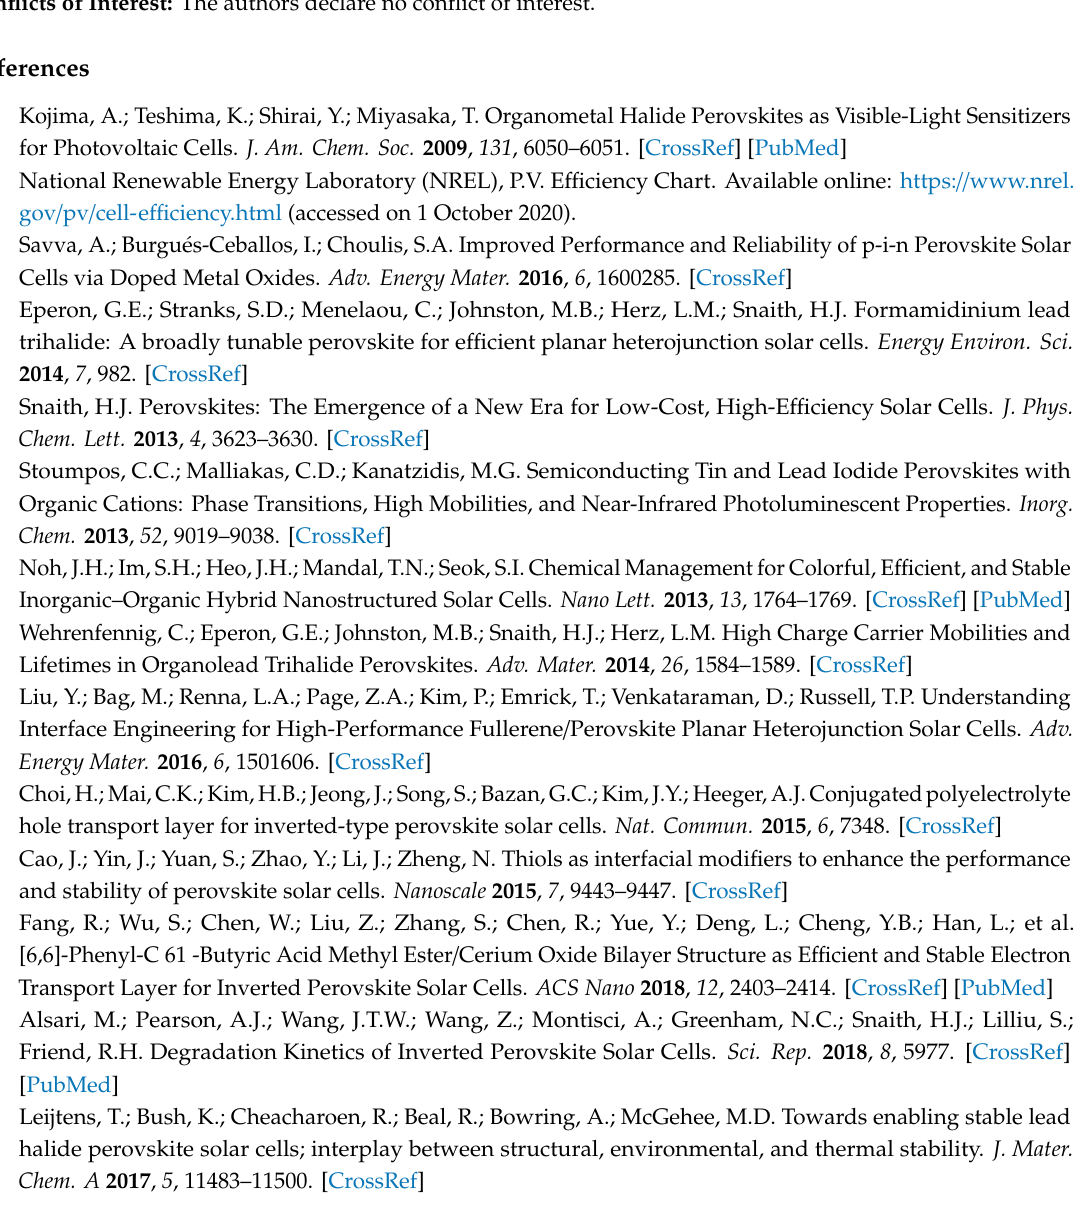
Figure S1: AFM images of: (a) ITO / Cu:NiOx / Pvsk, (b) ITO / Cu:NiOx / β -alanine / Pvsk; Figure S2: contact angle film measurements of (a) Cu:NiOx, (b) Cu:NiOx / alanine; Figure S3: (a) transmittance spectra ITO / Cu:NiOx, ITO / Cu:NiOx / alanine, and (b) absorbance spectra ITO / Cu:NiOx / Pvsk, ITO / Cu:NiOx / β -alanine / Pvsk; Figure S4: average PCE and SD for the optimized devices based on Cu:NiOx (20 nm); Figure S5: (a) Nyquist data and fitting for (a) R tr and (b) R rec ; Figure S6: J / V characteristic of optimized ITO / Cu:NiOx / β -alanine / Pvsk / PC 70 BM / BCP /